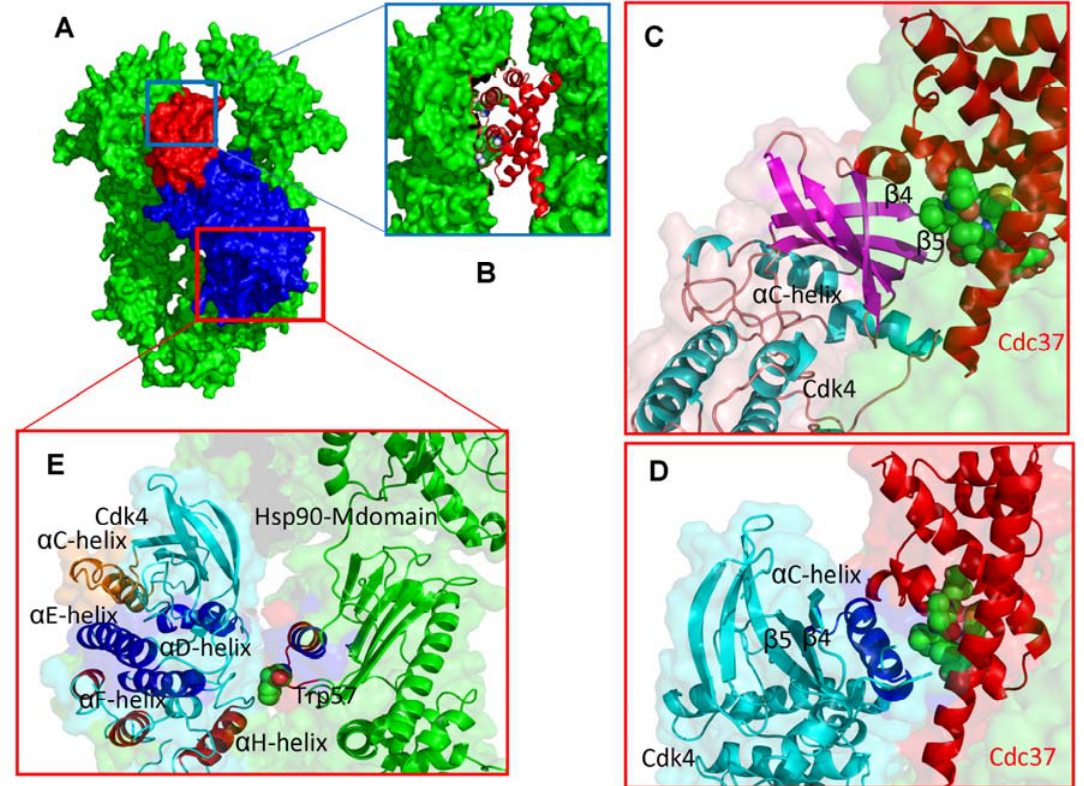
Figure 7. Structural Mapping of the Intermolecular Interfaces in the Hsp90-Cdc37-Cdk4 Docked Complexes ( A ) Structural overview of the low-energy docked complexes. The Hsp90 dimer is shown in green, Cdc37 is colored in red and Cdk4 is displayed in blue. ( B ) A close-up of the intermolecular interface between M-domain of Cdc37 (ribbon/sticks representation, colored in red) and Hsp90-NTD (surface representation, colored in green). ( C ) Structural details of the Cdk4-Cdc37 interface from the first low energy binding mode. The Cdc37 motif 190–LVIWCI-195 interfaces with the β 4 and β 5 strands of the N-terminal kinase lobe. Cdc37 is shown in red ribbons and the interacting Cdc37 helix is shown in spheres with atom-based coloring scheme. The interacting elements of Cdk4 are in blue ribbons, the rest of Cdk4 in cyan ribbons. ( D ) The Cdk4-Cdc37 interface from alternative low energy binding mode. The α C-helix region of Cdk4 interacts with the Cdc37 recognition motif. ( E ) A close-up of the interface between the C-terminal kinase lobe and the middle domain of